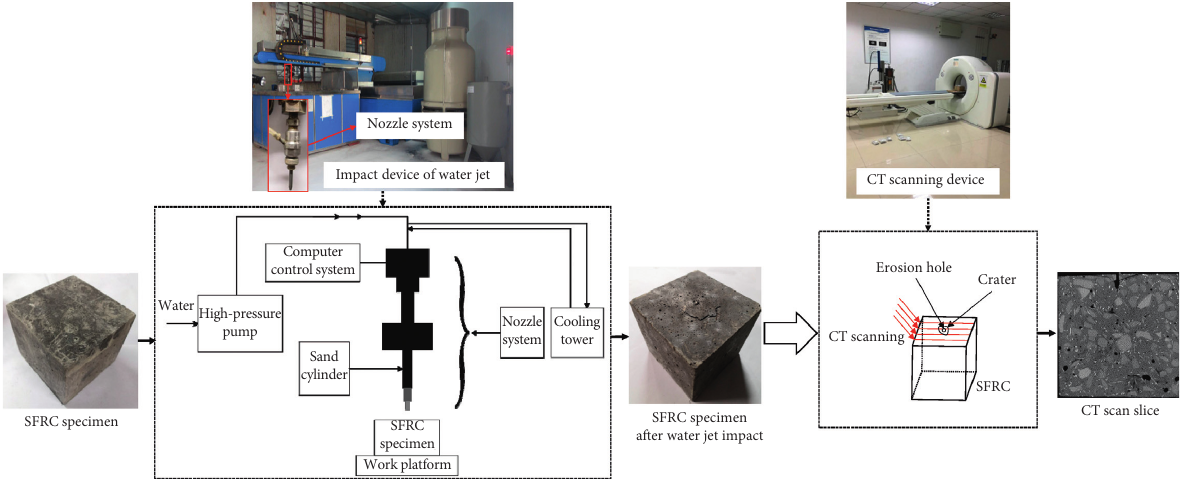
Figure 7: Experimental equipment and procedure.